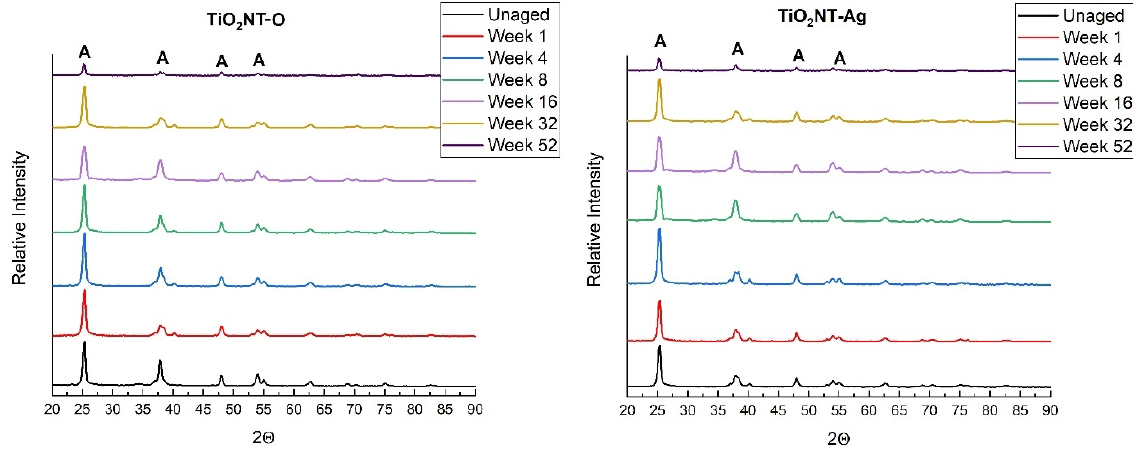
Figure 8. XRD diffraction graphs taken on the samples anodized in the organic electrolyte and aged for different durations.